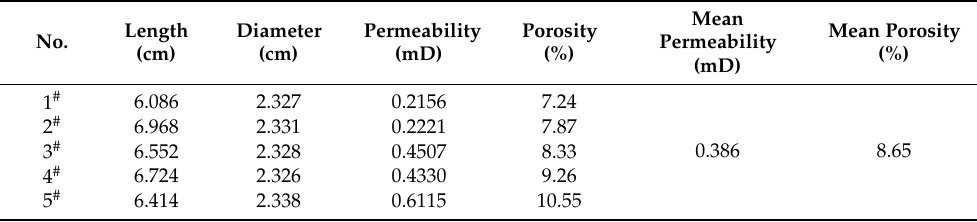
Table 2. Related physical property parameters of natural short cores.